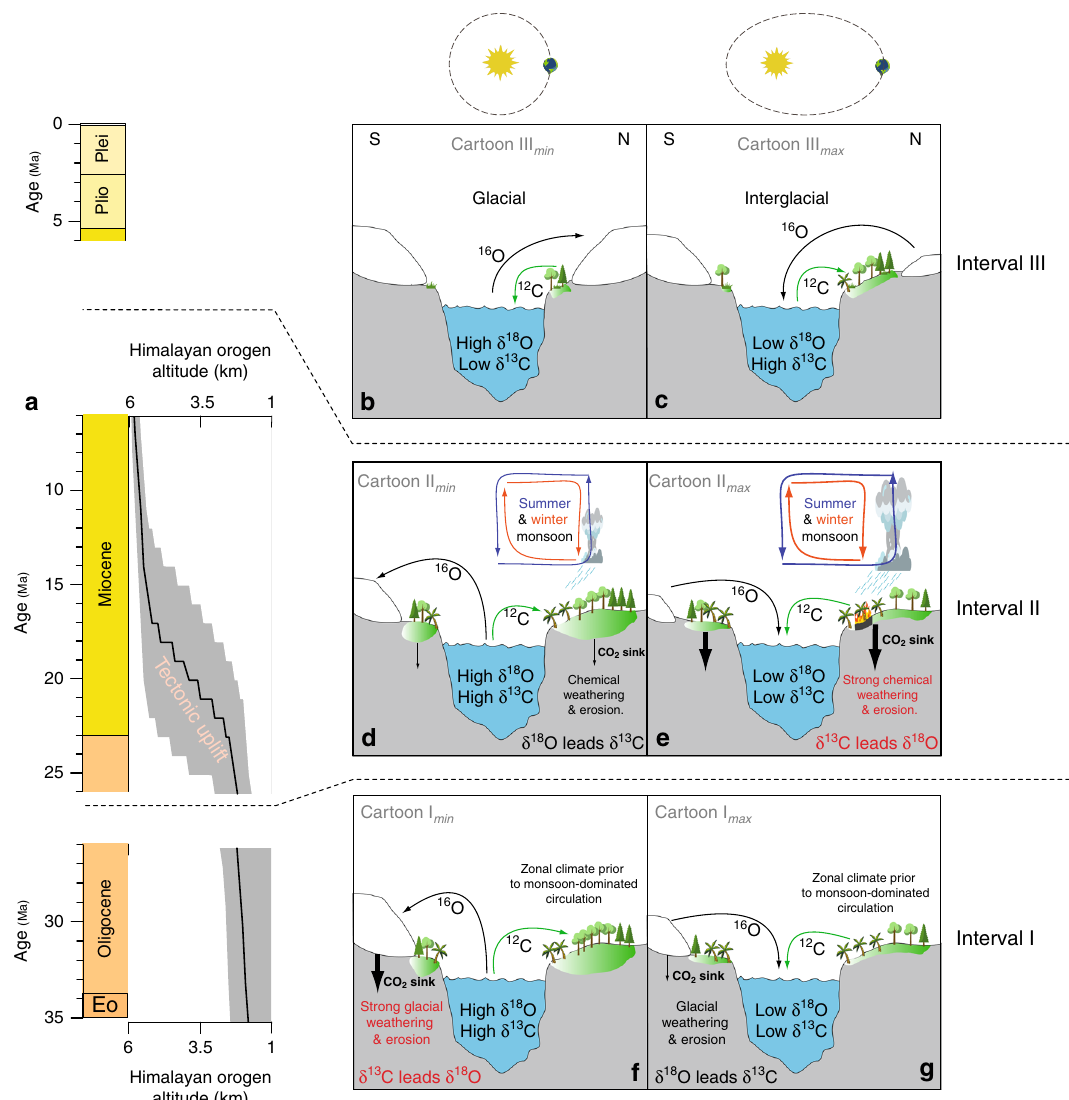
Fig. 4 Cartoons illustrating the proposed concepts for the observed phasing patterns between δ 13 C and δ 18 O. a Geologic time-scale of the last 35 Ma, and evolution of the Himalayan Orogen (after Ding et al. 64 ). b , c The anti-phase behaviour in Interval III is primarily ascribed to high-latitude biome dynamics. d – g During Intervals I and II, when in-phase behaviour is observed, continental rock weathering forms the key mechanism in our hypotheses, with the carbon cycle ( δ 13 C) leading the climate – cryosphere system ( δ 18 O) when the continental rock weathering CO 2 sink is enhanced. This occurs during eccentricity minima (strong glacial activity) during Interval I, but during eccentricity maxima (strong monsoonal circulation) during Interval